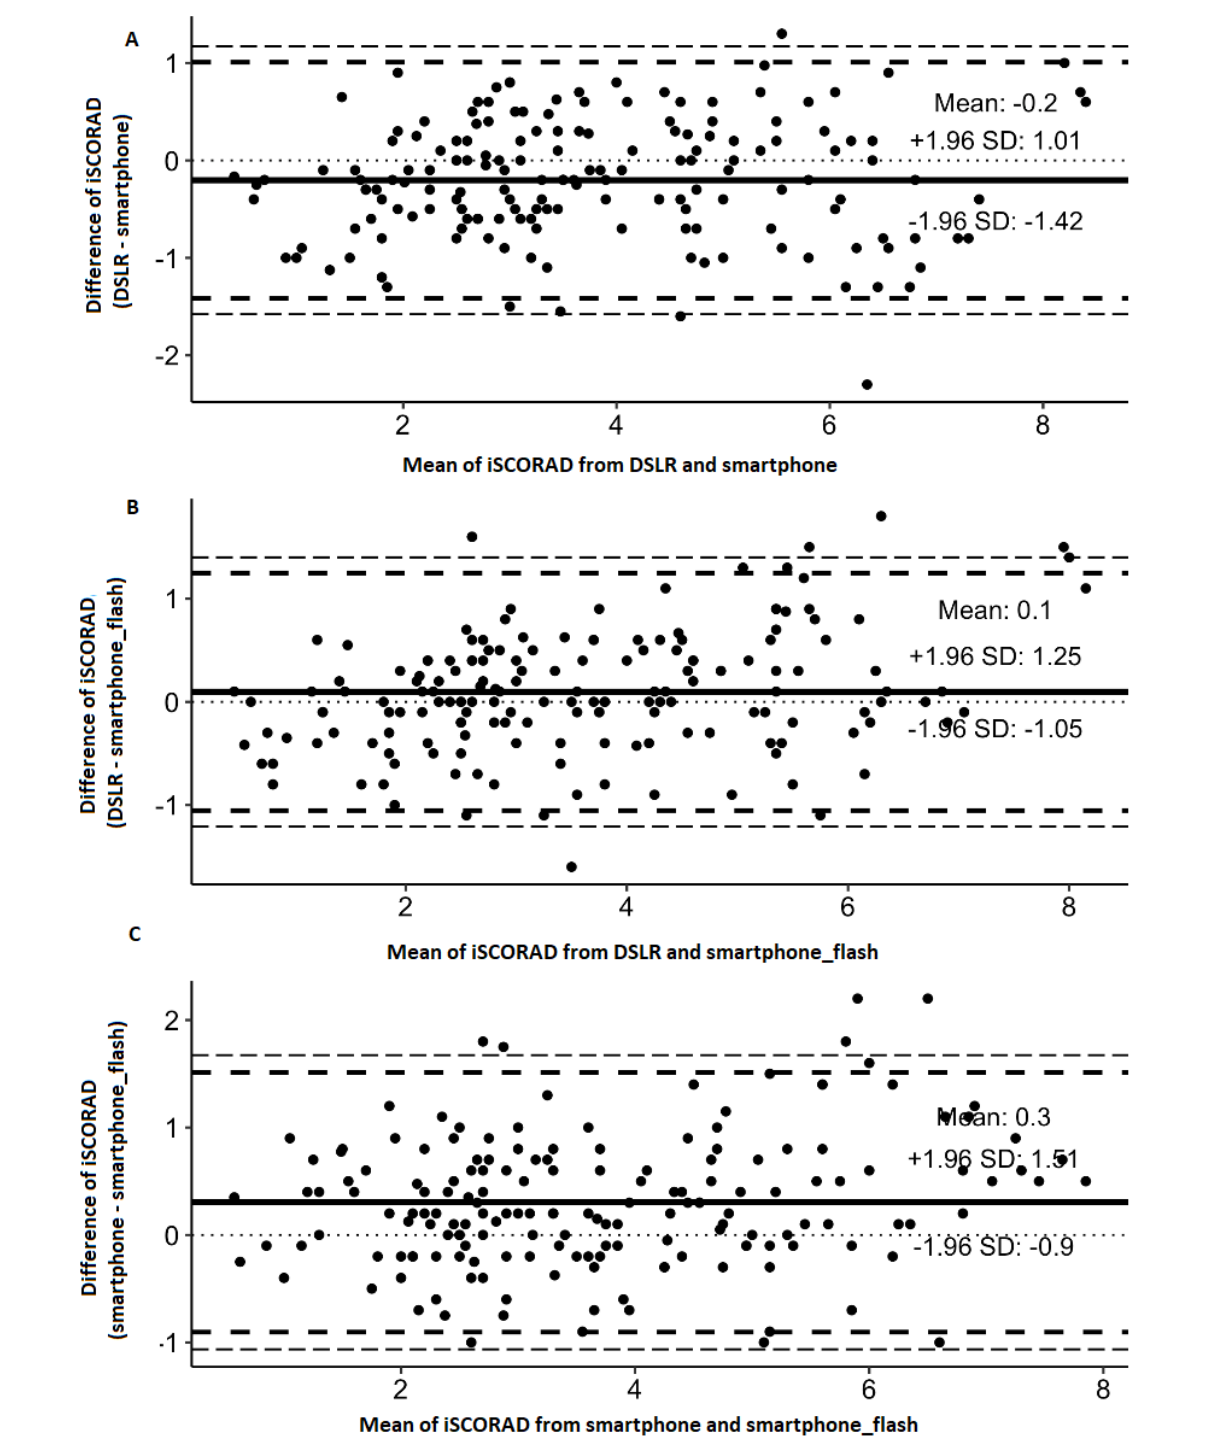
Figure 3. A Bland-Altman plot of the difference between the intensity items of Scoring AD (iSCORAD) remotely assessed based on (A) digital single-lens reflex camera (DSLR) camera and smartphone without flash, (B) DSLR camera and smartphone with flash, and (C) smartphone with and without flash. The solid line represents the mean difference, the broken line the 1.96 SD, and the dotted line represents